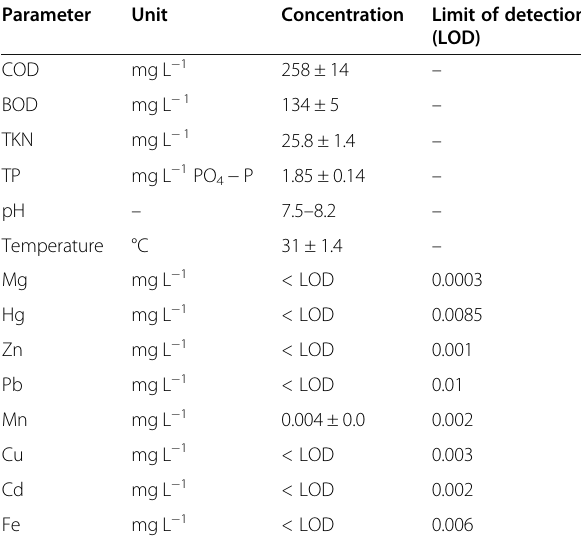
Table 1 Characteristics of the leachate